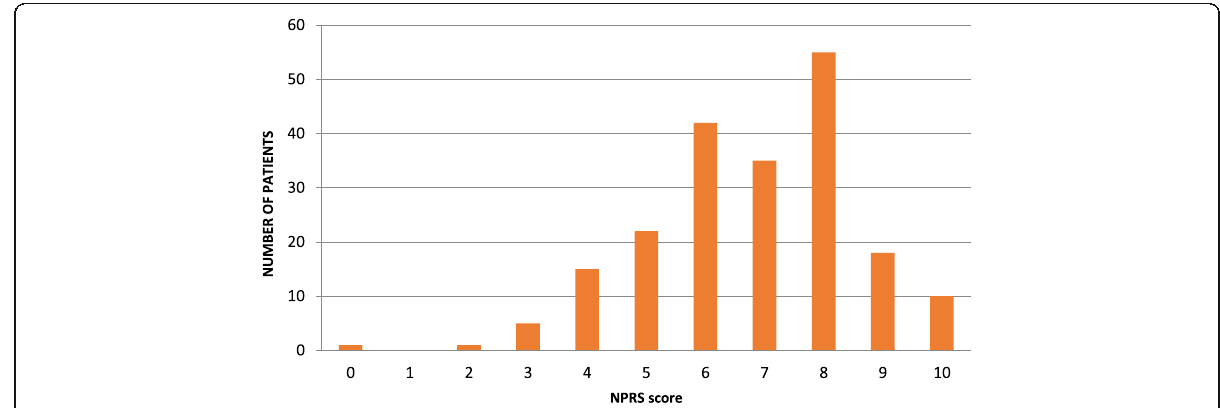
Fig. 3 Responses to question 9: Average reported pain (Numeric Pain Rating Scale score) over the previous week among those willing to consider medical marijuana ( n = 204). Mean = 6.79/10, SD =